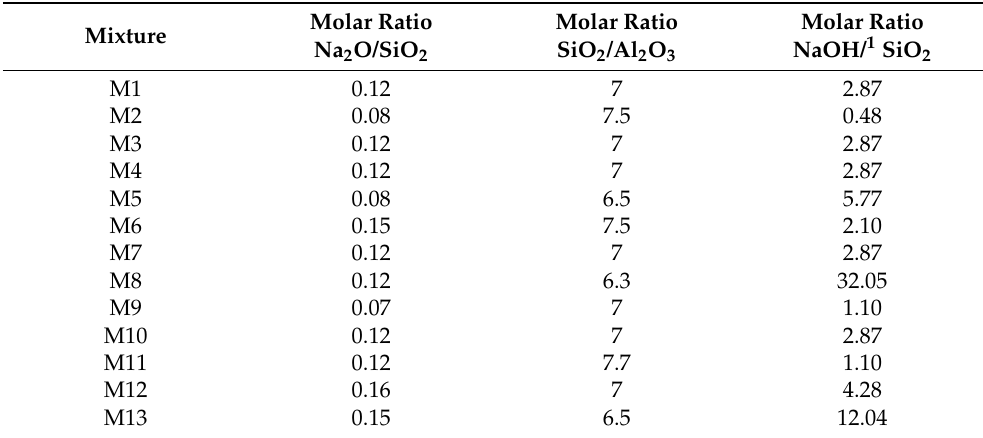
Table 1. Molar ratios for the synthesis of hybrid cements obtained from the RSM design with Minitab 18